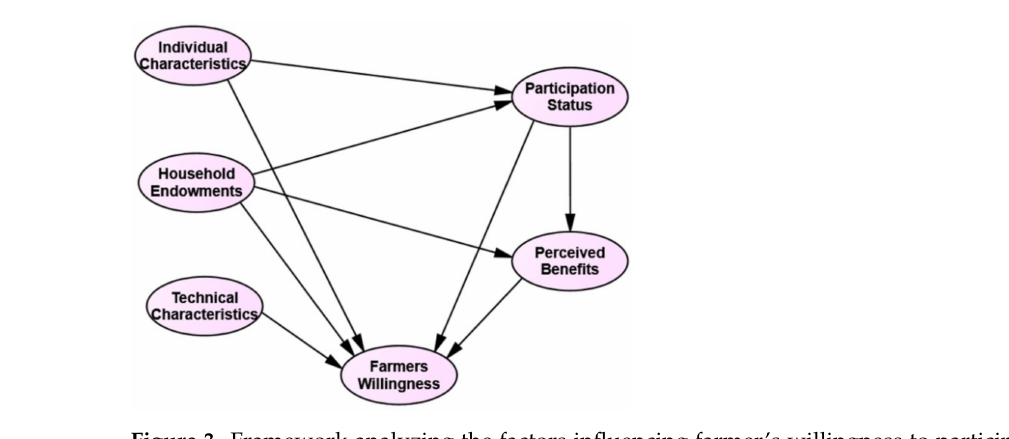
Figure 3. Framework analyzing the factors influencing farmer’s willingness to participate in soil